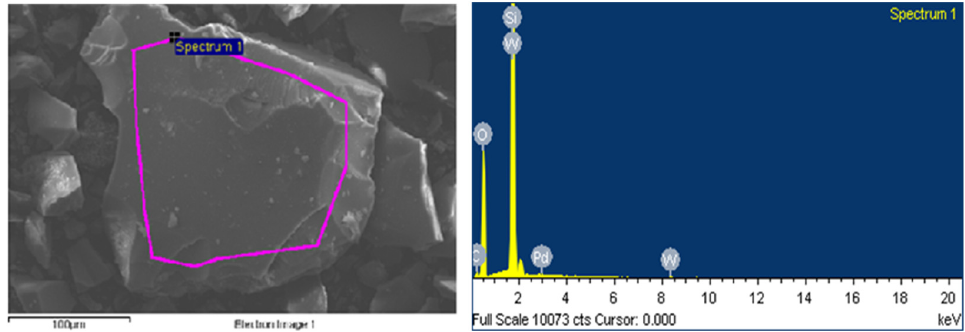
Figure 5. EDX analysis of the 1%Pd-HPW/SiO 2 bi-functional catalyst.